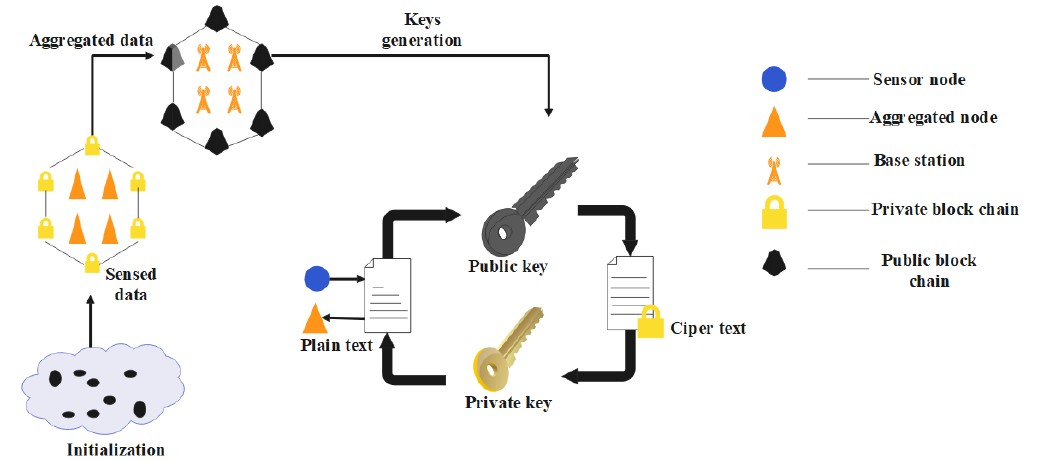
Figure 1. An overall flow of blockchain based WSN.